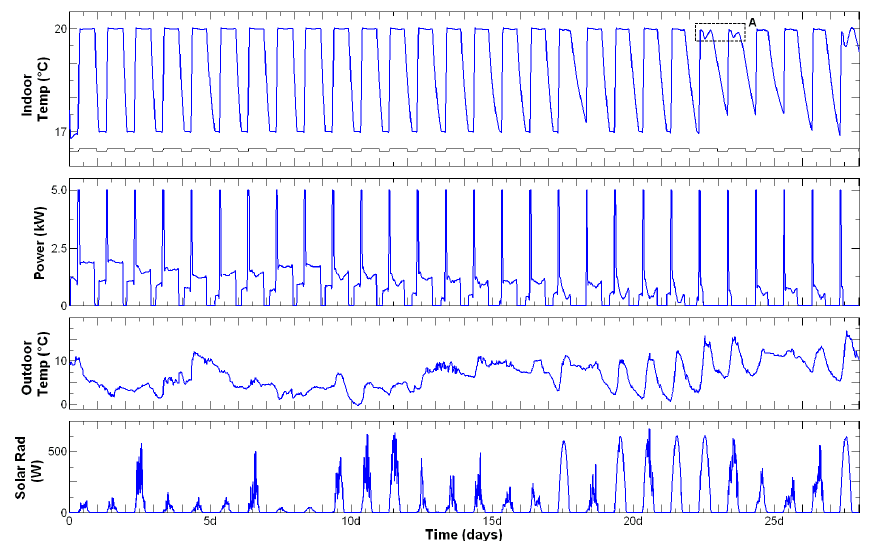
Figure 4. Model Predictive Control (MPC) applied to the dwelling model, heat system consumption, outdoor temperature and solar radiation. Black line represents the temperature reference changes between 20 and 17 °C.